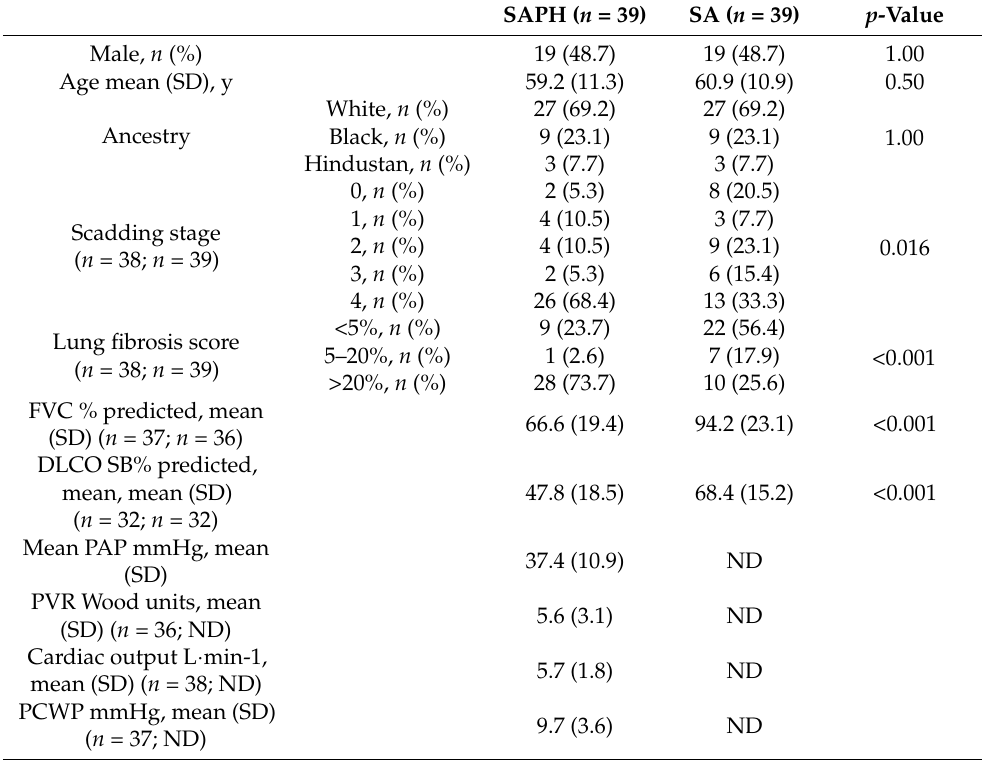
Table 1. Baseline characteristics of SAPH and SA patients. FVC % predicted: forced vital capacity % of predicted value; DLCO SB % predicted: single-breath diffusing capacity of the lung for carbon monoxide % predicted; Mean PAP: mean pulmonary arterial pressure; PVR: pulmonary vascular resistance; PCWP: pulmonary capillary wedge pressure; ND: parameter was not